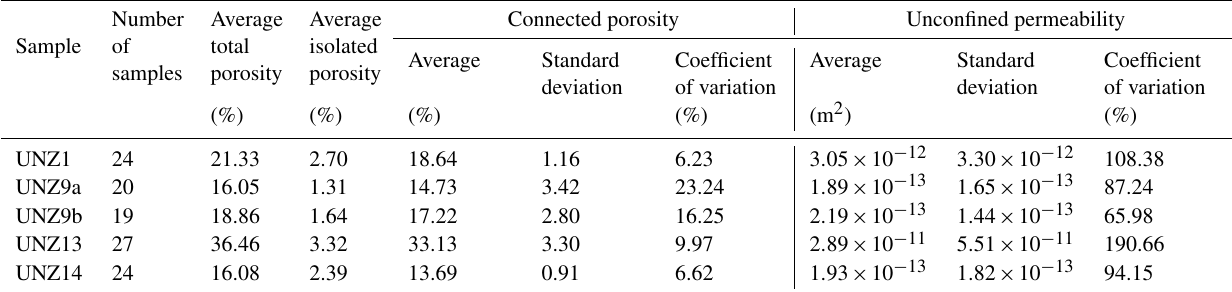
Table 1. Sample (core and disc) porosity and unconfined permeability overview. Connected porosity Unconfined permeability Average Average Number isolated Sample of Average samples